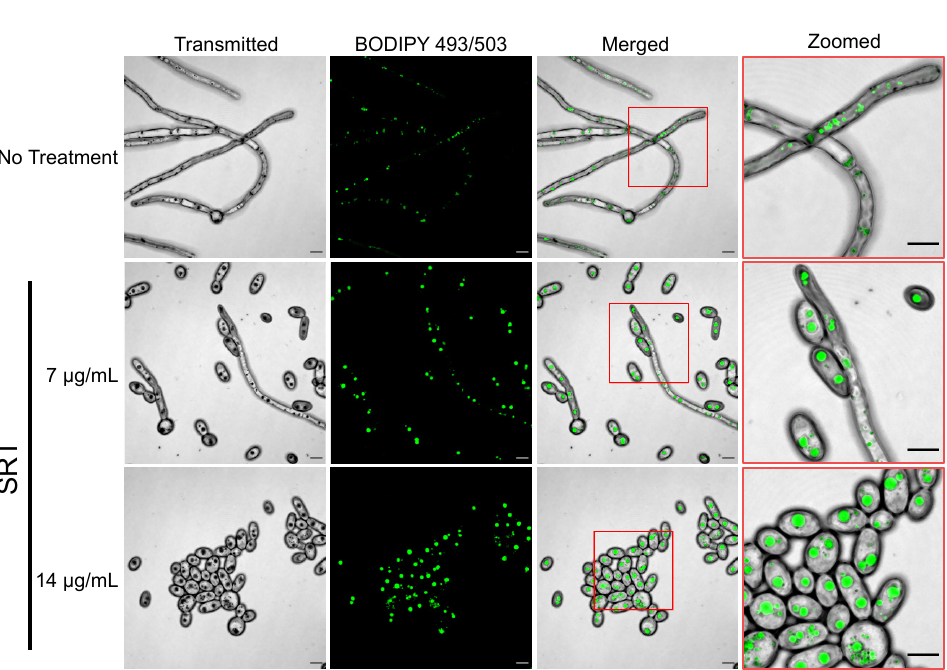
S. cerevisiae Figure 3. Cont